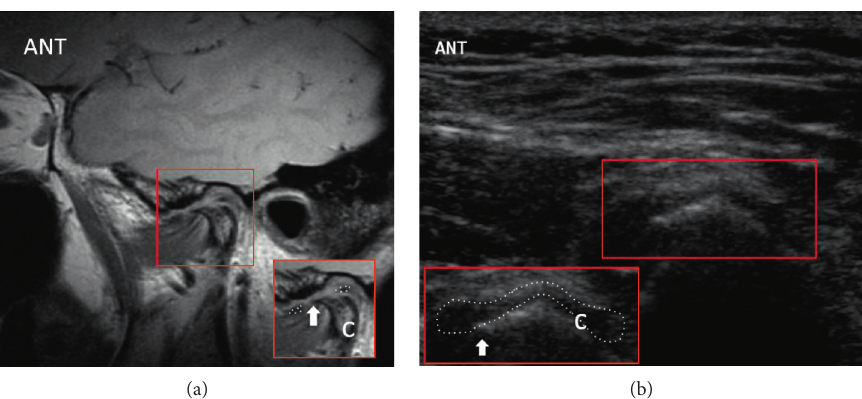
Figure 7: Osteoarthritis with the deformed articular surface of the condyle with a large anterior marginal osteophyte and deformed disc with central thinning on (a) MR and (b) ultrasound. A focal annotated view was provided to aid visualization with the articular disc outlined with a dotted contour and the osteophyte indicated by an arrow; anterior � “ANT”; condyle �